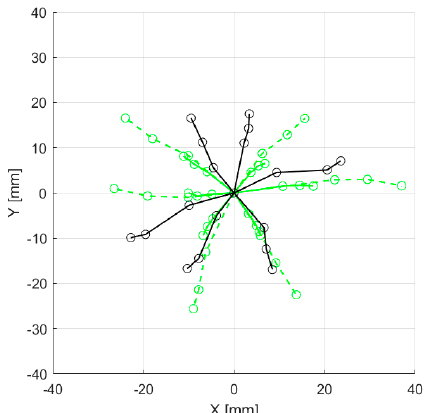
Figure 16. X-Y projection of the workspace with prototype D in black and prototype B in green (solid line: with antagonistic wires, dotted line: without antagonistic wires).